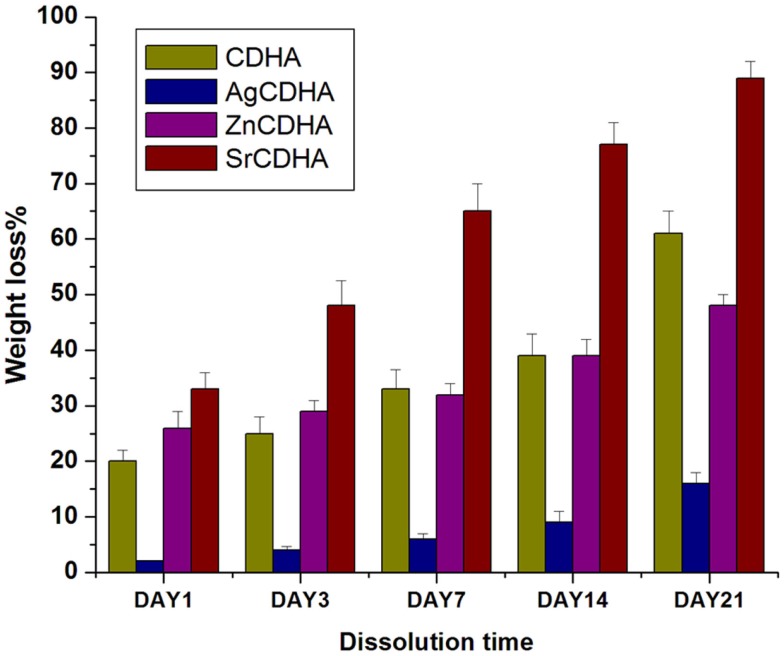
In vitro solubility studies showing the weight loss of ion substituted CDHAs in PBS of pH 7.4 at 37°C (n = 3; data shown as mean ± SD; p < 0.0001, two-way ANOVA).